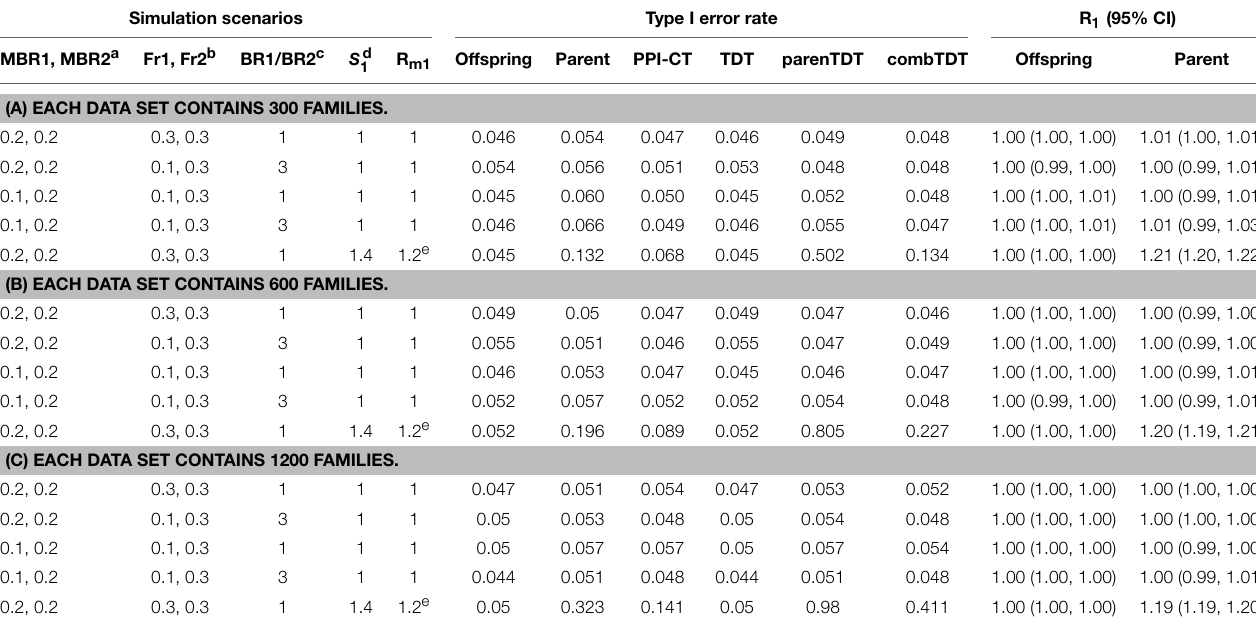
TABLE 1 | Type I error rates under the null, with disease affecting one